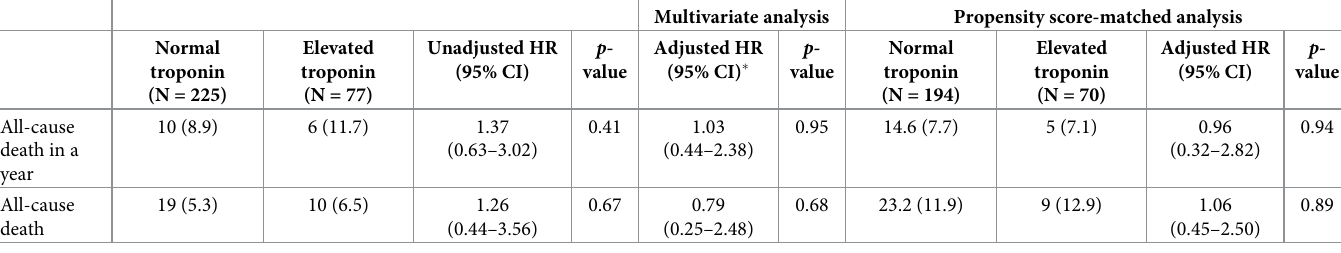
Table 4. All-cause death in the preoperative group (Entire and propensity-matched populations).